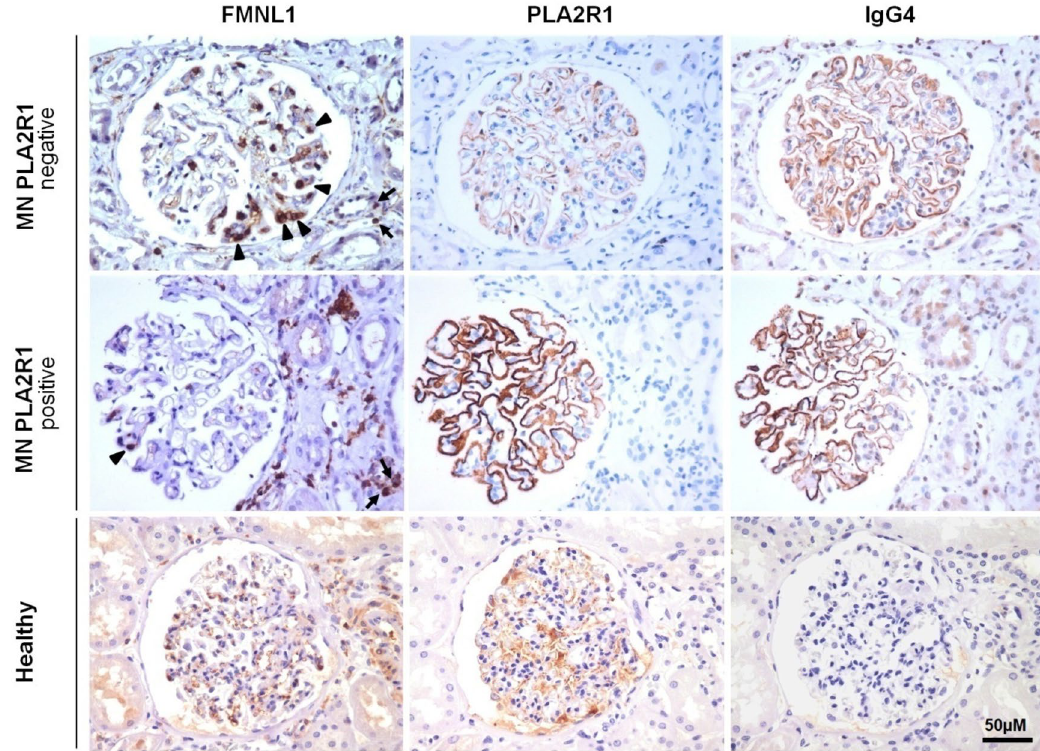
Figure 6. FMNL1 expression in MN biopsies and normal renal tissue. Immunohistochemistry was performed using FMNL1, PLA2R1 and IgG4 antibodies on PLA2R1 negative and positive MN biopsies and on normal renal tissue. In MN, FMNL1 was detected in circulating cells within glomerular capillaries (arrow heads) and in some cells in the interstitial space (arrows). Glomerular FMNL1 staining was distinctly different from staining of PLA2R1 (PLA2R1 positive MN) and IgG4 (PLA2R1 positive and negative MN) and was particularly expressed in PLA2R1 negative MN (patient with secondary MN due to lymphoma, patient 10) compared with